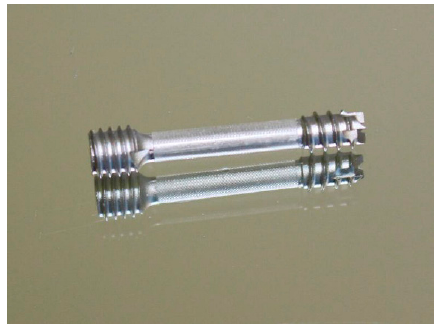
Figure 19. Overmolded screw.